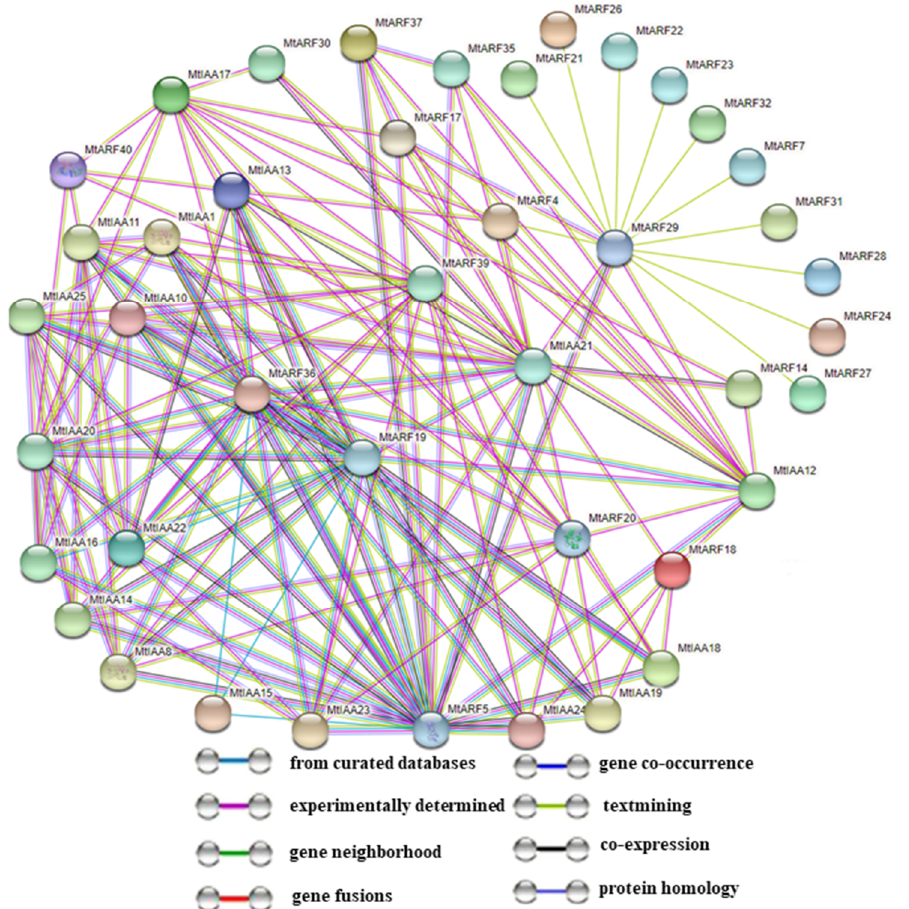
Figure 8. Predicted protein–protein interaction network of MtIAAs and MtARFs. The network contains 42 nodes (18 Aux/IAAs and 24 ARFs).